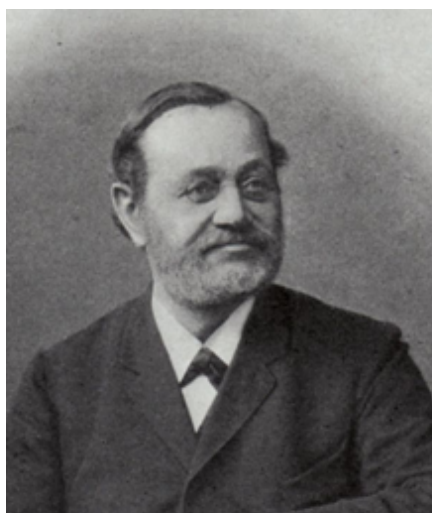
Figure 2: Gottfried Wilhelm Fl¨ugge (1904-1990)